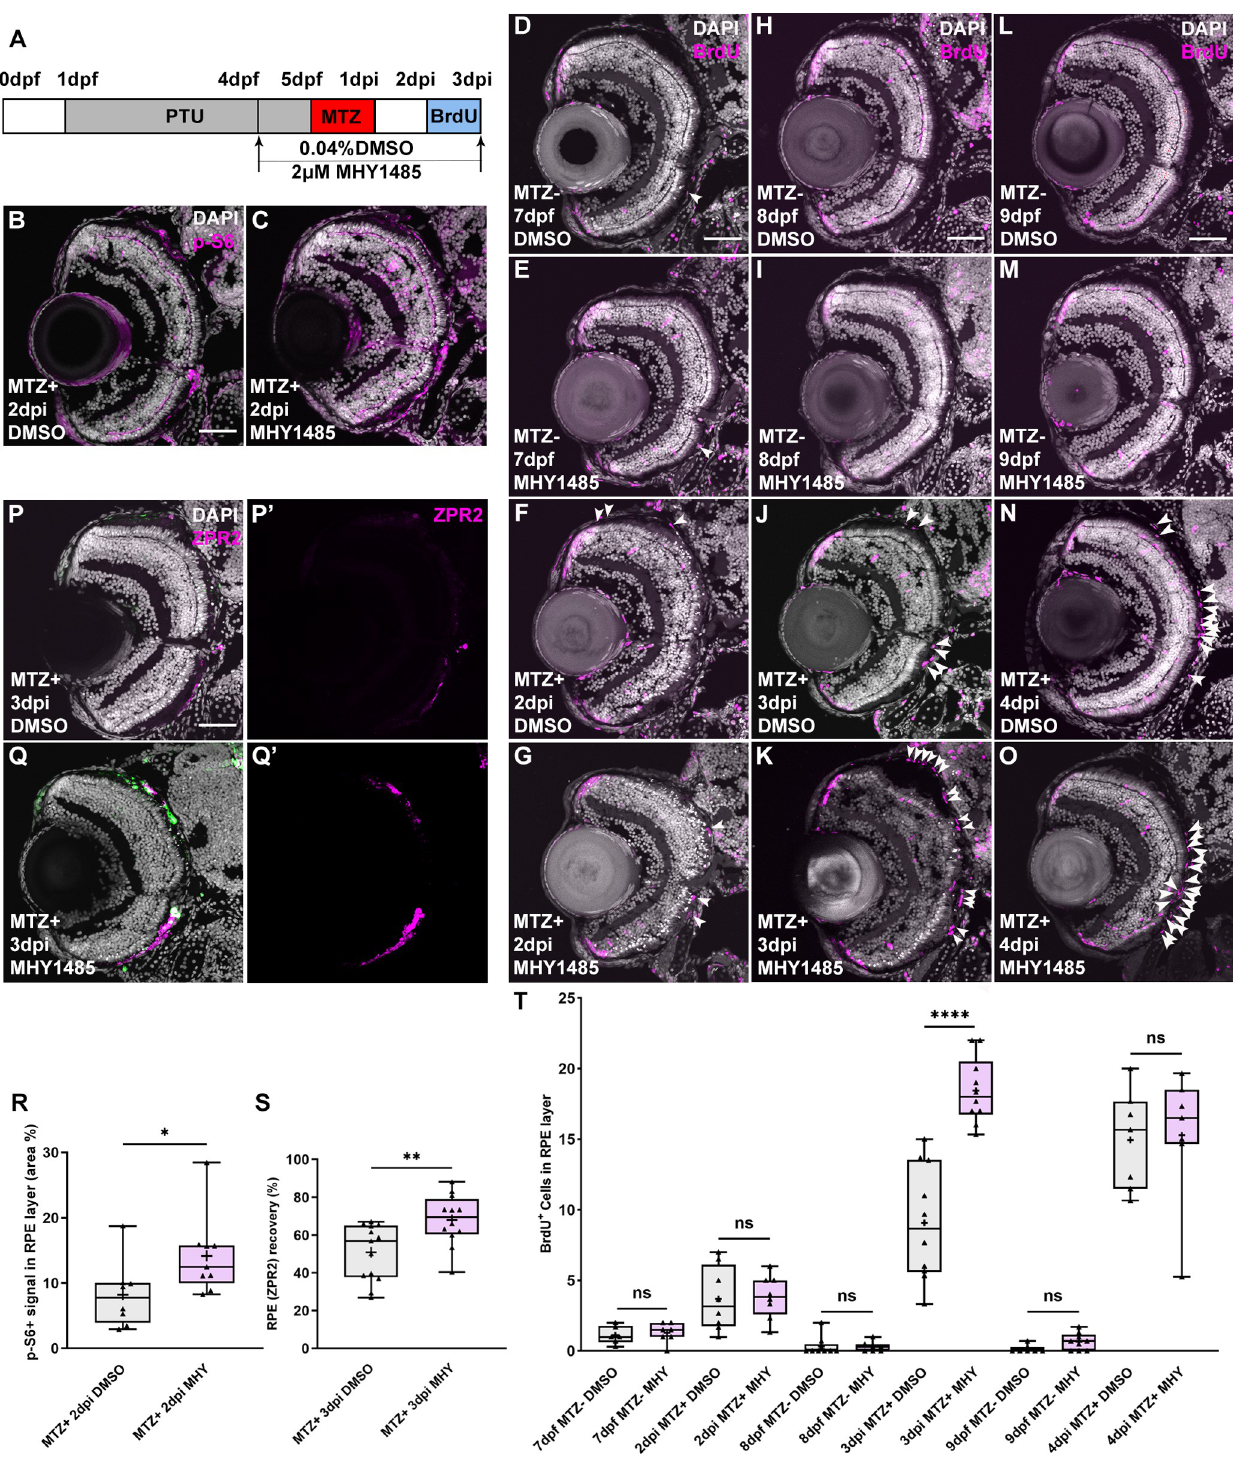
Fig 4. Pharmacological activation of mTOR signaling enhances RPE regeneration. (A) Schematic of the experimental paradigm showing the timeline for chemical treatments and ablation. (B,C) Immunofluorescent images of p-S6 staining on transverse cryosections from MTZ + DMSO- and MHY1485-treated larvae at 2dpi. Nuclei (white), p-S6 (magenta). (R) Quantification of p-S6 signal in the RPE layer showed a significant increase of p-S6 levels in MHY1485-treated larvae when compared to DMSO-treated controls. (D-O) Fluorescent images of BrdU immunostaining on cryosections from MTZ - and MTZ + DMSO- and MHY1485-treated larvae at (D-G) 7dpf/2dpi, (H-K) 8dpf/3dpi and (L-O) 9dpf/4dpi. White arrowheads highlight BrdU + cells in the RPE